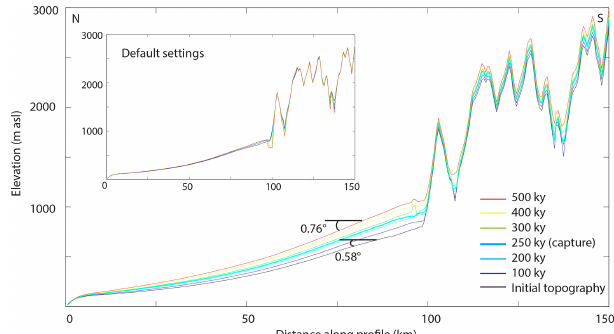
Figure 11. Evolution of a north–south topographic profile near the middle of the model during Experiment 5 (region-wide tilting). In- set shows that with default settings (Experiment 1), the slope of the megafan does not increase; regional tilting (Experiment 5) is needed to create an increasing northward slope through